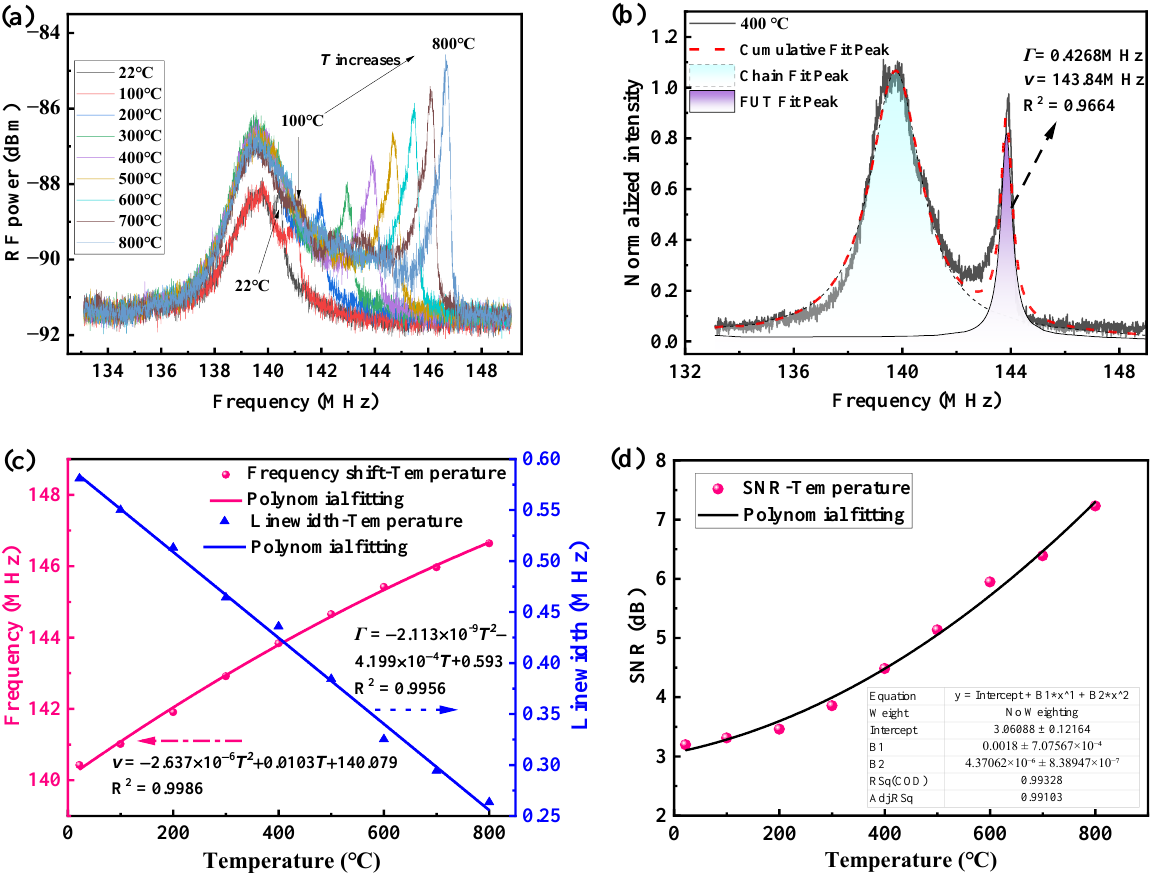
Figure 4. ( a ) Measured TR 2,7 mode induced depolarized GAWBS spectra at temperatures ranging from 22 ◦ C to 800 ◦ C; ( b ) Normalized TR 2,7 mode induced depolarized GAWBS spectrum at 400 ◦ C and the corresponding Lorentzian multi-peak fitting result; ( c ) Resonance frequency and linewidth of TR 2,7 mode induced depolarized GAWBS spectra as a function of temperature; ( d ) Measured SNR of the TR 2,7 mode induced depolarized GAWBS spectra as a function of temperature. In order to accurately quantify the variation of resonance frequency and linewidth, the spectrum is normalized, and Lorentzian multi-peak fitted as exemplified in Figure 4b, which shows the depolarized GAWBS spectrum of TR 2,7 mode measured at 400 ◦ C. As illustrated in Figure 4b, both of the measured depolarized GAWBS spectral peaks of TR 2,7